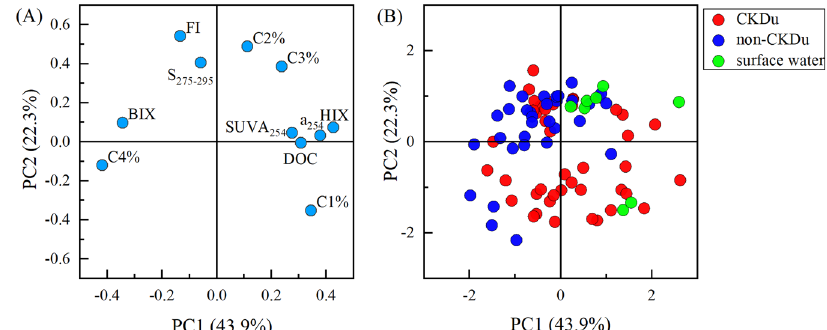
Fig. 3 Principal component analysis (PCA) diagram of spectral indicators and fl uorescence components. A loadings (variables), B plots of scores